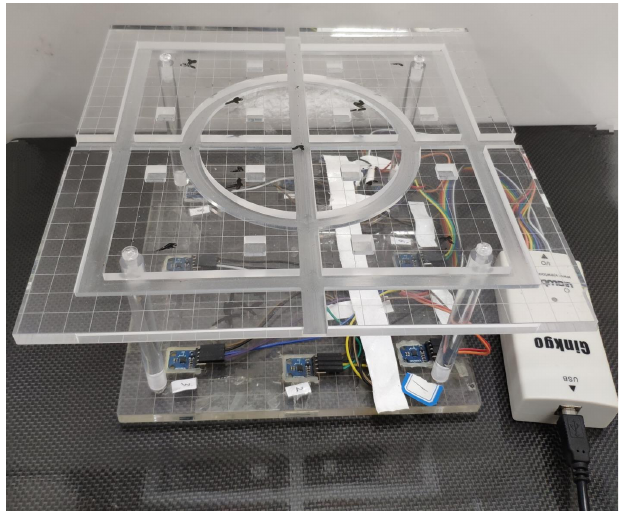
Figure 7. Experimental platform. The magnetic sensors array contained 8 HMC5883L sensors. Signals from the sensors were transferred to a PC via an IIC to a USD adapter. A plane with a circle path and rectangular path was placed above the sensor array to carry out the